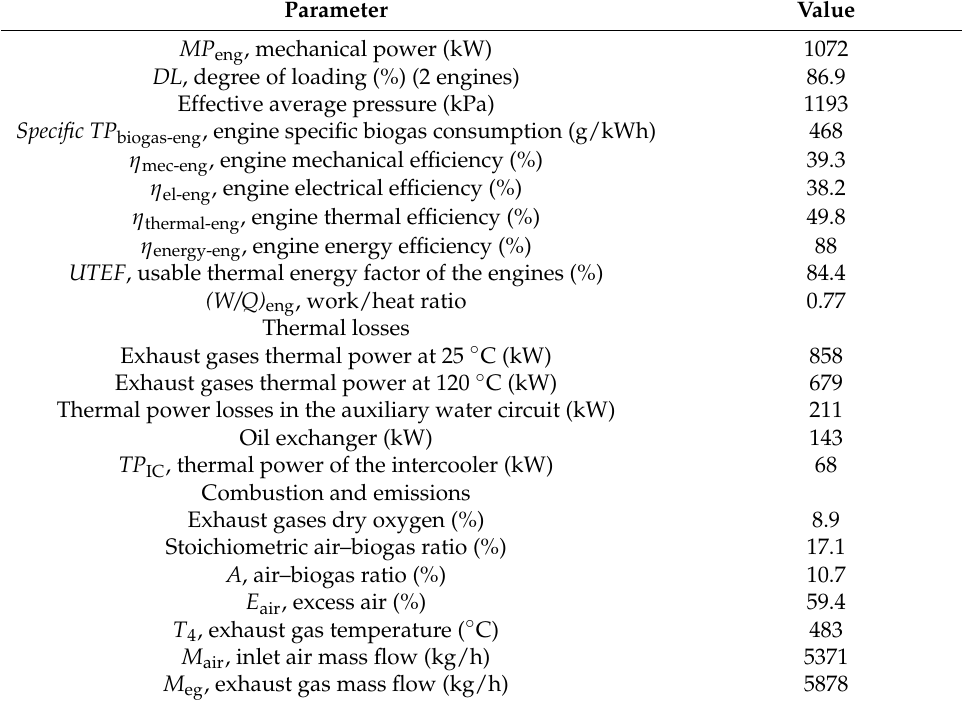
Table 7. Parameters of biogas engines at the operating